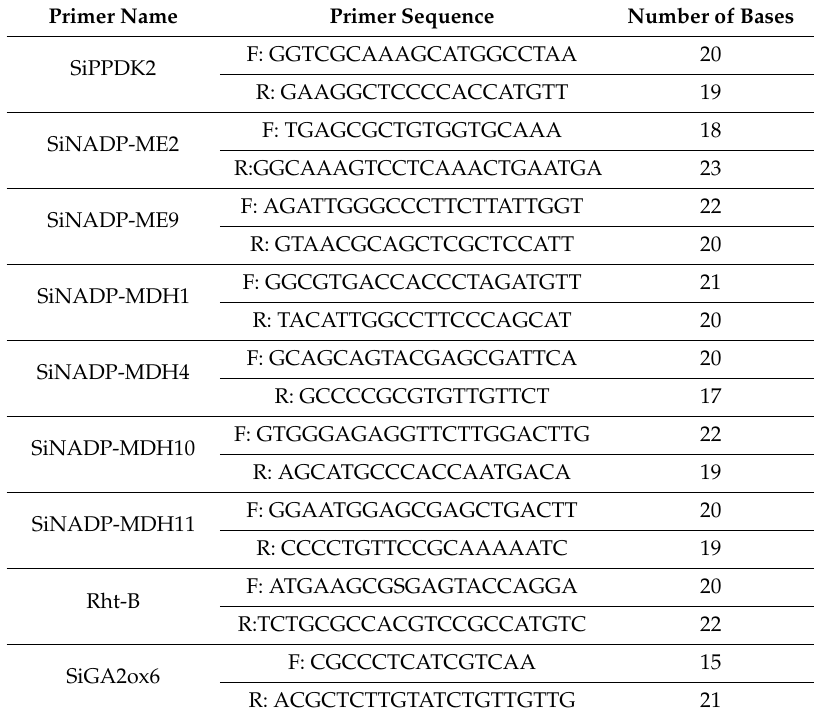
Table 1. List of primers used for quantitative realtime-polymerase chain reaction (qRT-PCR)